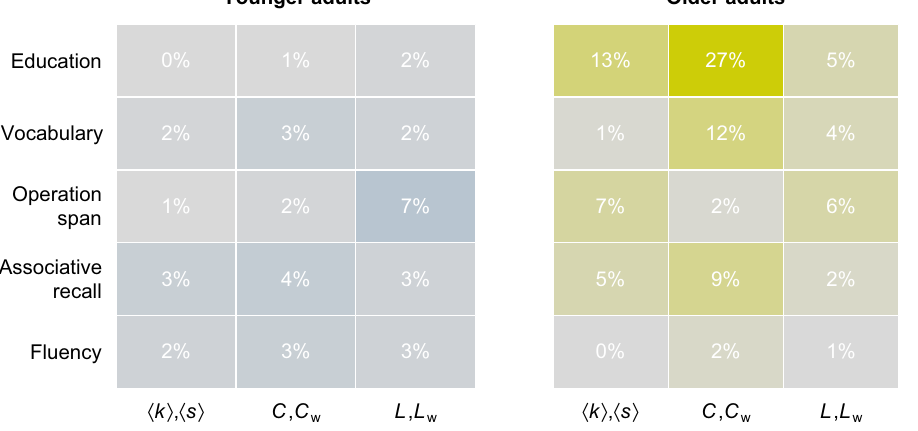
Figure 7. Shared variances between network structure, education, and cognitive performance. Numbers display the average proportion of shared variance across w min ∈ [ 0, .1, .2, .3, .4 ] and weighted and unweighted versions of individuals’ networks. Note: (cid:31) s (cid:30) , (cid:31) k (cid:30) —Differences in average strengths/degrees (unweighted); C , C w —Difference in average clustering coefficients of weighted/unweighted networks; L , L w —Difference in average shortest path lengths of weighted/unweighted